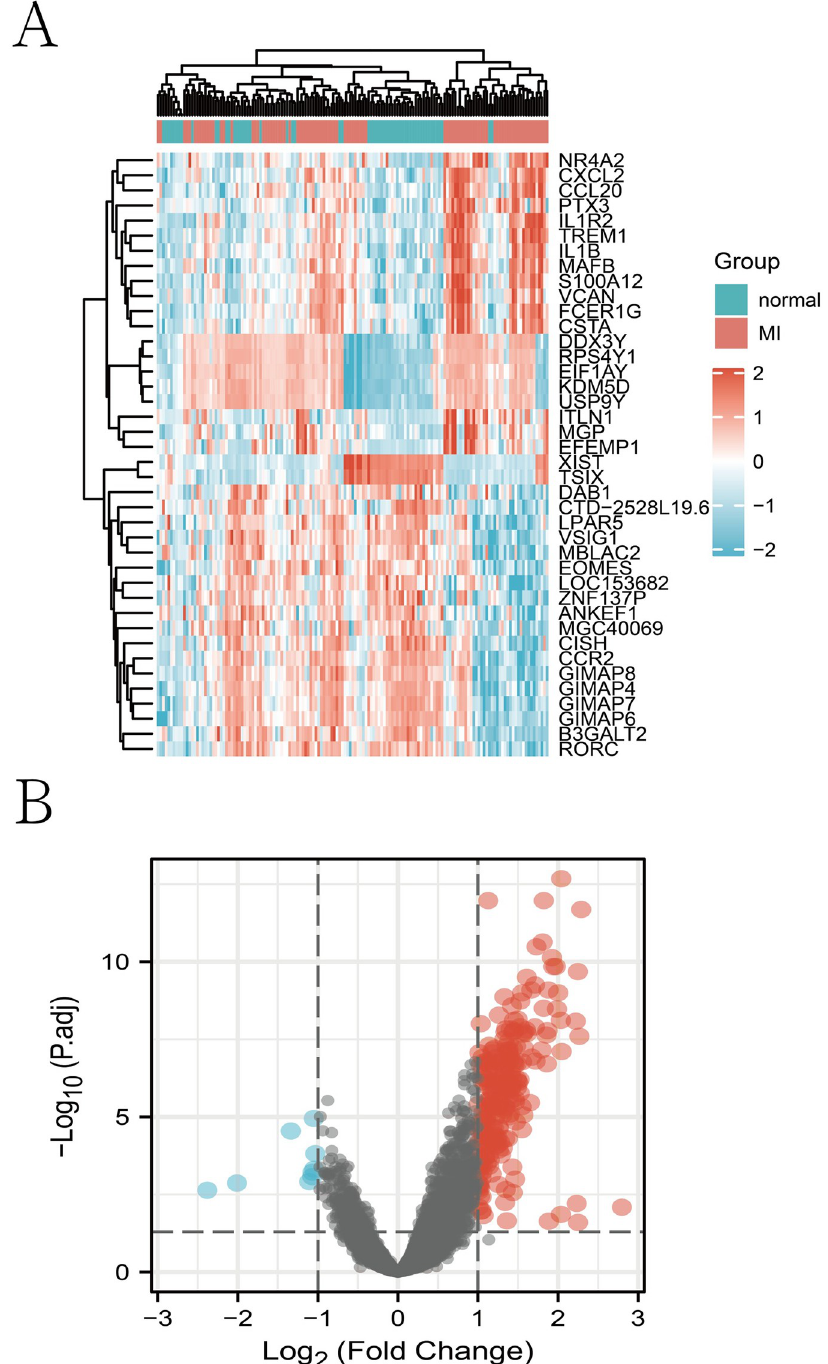
Fig 1. A. Heat map of gene expression . Heat map of gene expression with expression levels shown as rectangles of different colors: red indicates high levels of differential genes, while Combined with the relationship between their expression levels blue indicates low levels of differential genes. B. Vulcano plot . Vulcano plot showing the difference in DEGs between AMI samples and healthy controls. Genes that are overexpressed are shown in red, while temporarily unrelated genes are shown in black. Genes that are downregulated are shown in